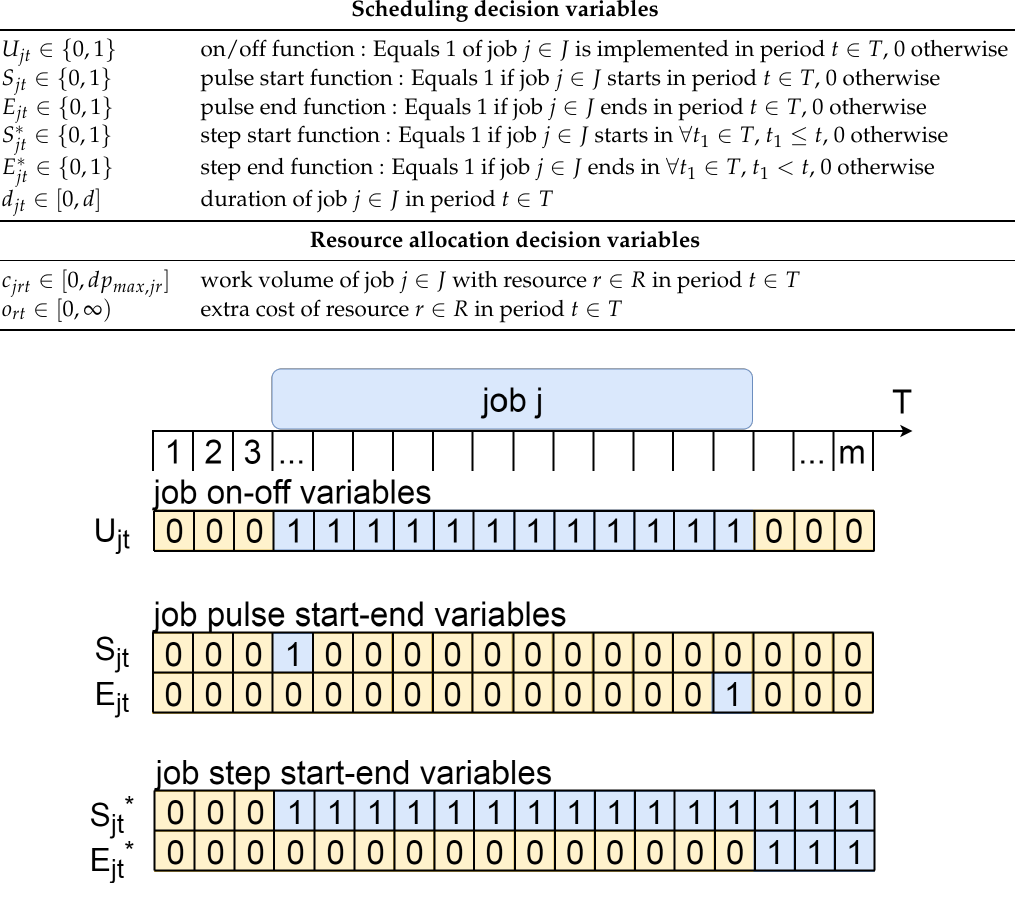
Figure 1. Three different ways to utilize binary scheduling